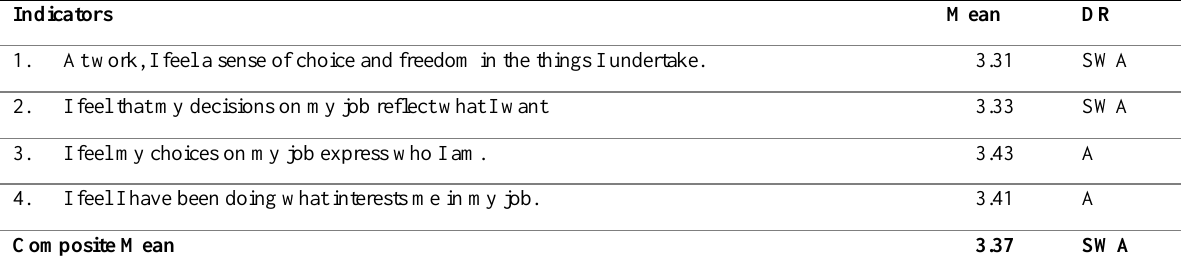
Table 2: The Workplace Well-being of Divine Word Colleges in the Ilocos Region as to Autonomy Need Satisfaction Indicators Mean